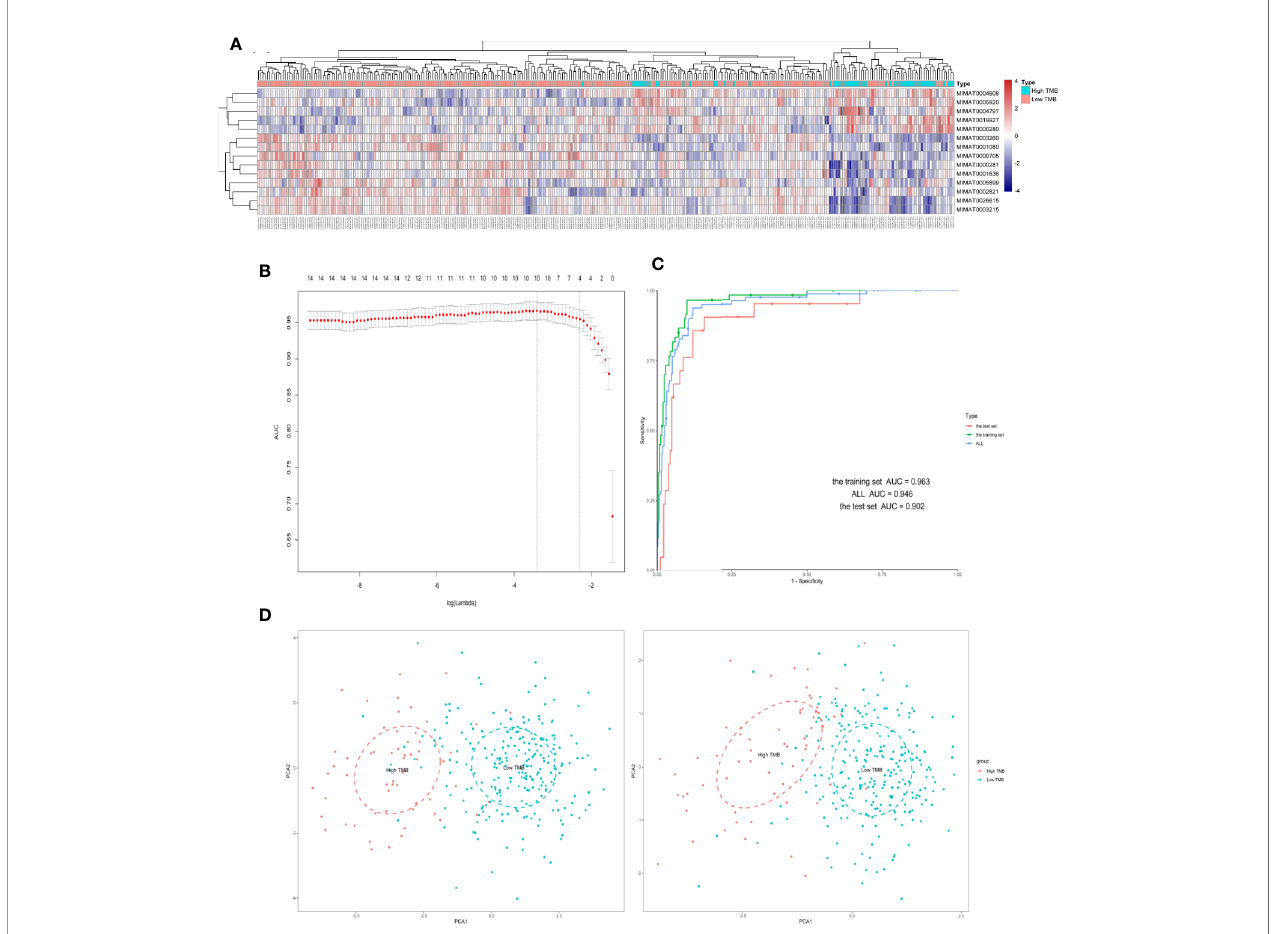
FIGURE 2 | Four differently expressed microRNAs were identi fi ed from The Cancer Genome Atlas (TCGA) in samples of colorectal cancer (CRC). (A) Hierarchical clustering of expression patterns from differentially expressed microRNAs discriminate between high and low TMB. (B) The microRNAs (miRNAs) selection results of the LASSO mode. (C) Receiver operating characteristic curve of the training/test set. (D) Principal component analysis (PCA) plot of all samples before and after LASSO variable reduction. LASSO, least absolute shrinkage and selection